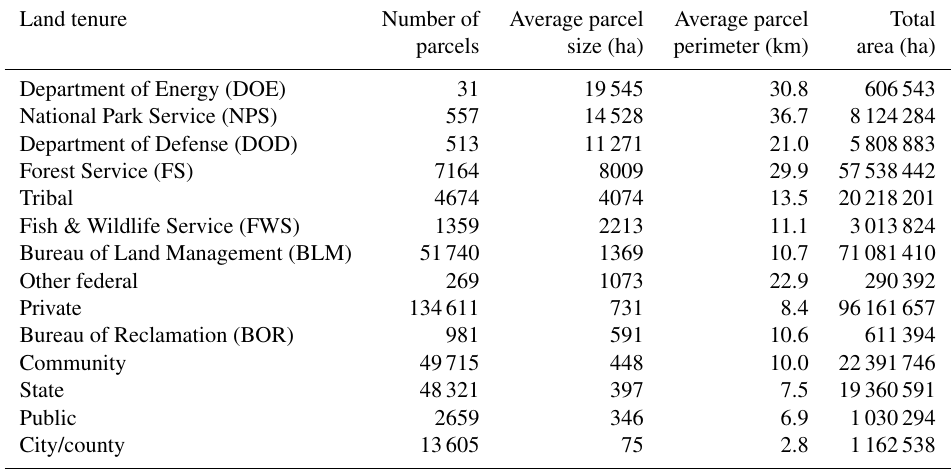
Table 1. Average parcel area and perimeter, total number of parcels, and total area for each land tenure across the western US. See text for definition of the “other federal” and “public”